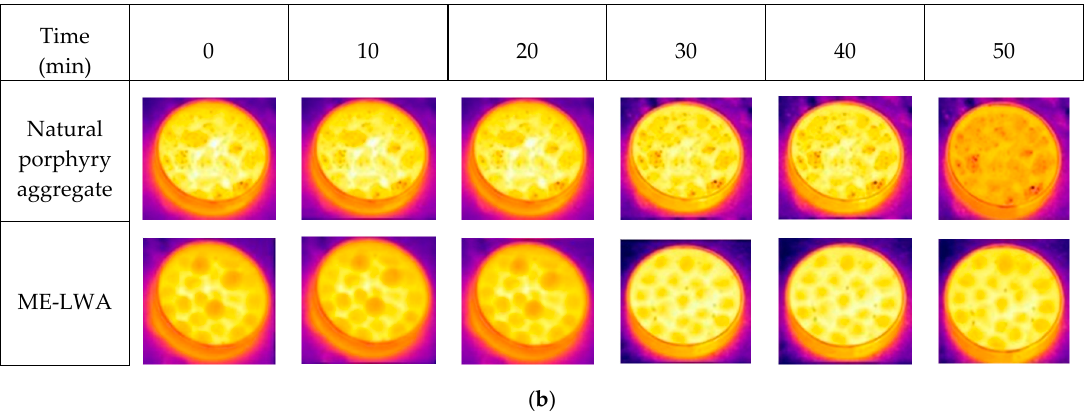
Figure 14. ( a ) Temperature differences versus time and ( b ) thermal images of natural porphyry aggregate and ME-LWAs over a period of 50 minutes.